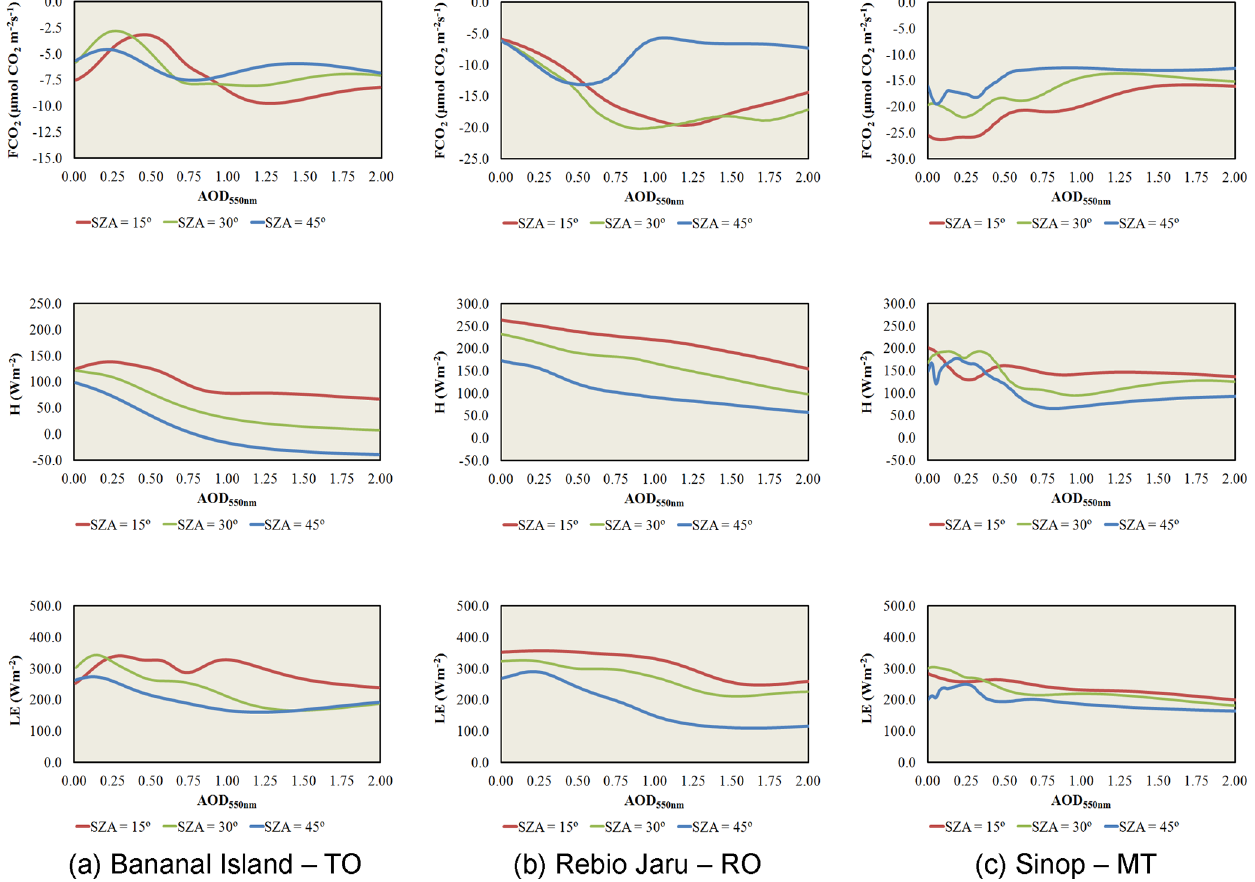
Figure 8. Modeled FCO 2 (µmolCO 2 m − 2 s − 1 ), H (Wm − 2 ), and LE (Wm − 2 ) via ANNs versus AOD550nm for three SZAs (15, 30, and 45 ◦ ) for three study sites. Values of temperature, VPD, and u ∗ were statistically modeled with ANNs built from meteorological data. PARi and PAR dif were obtained through